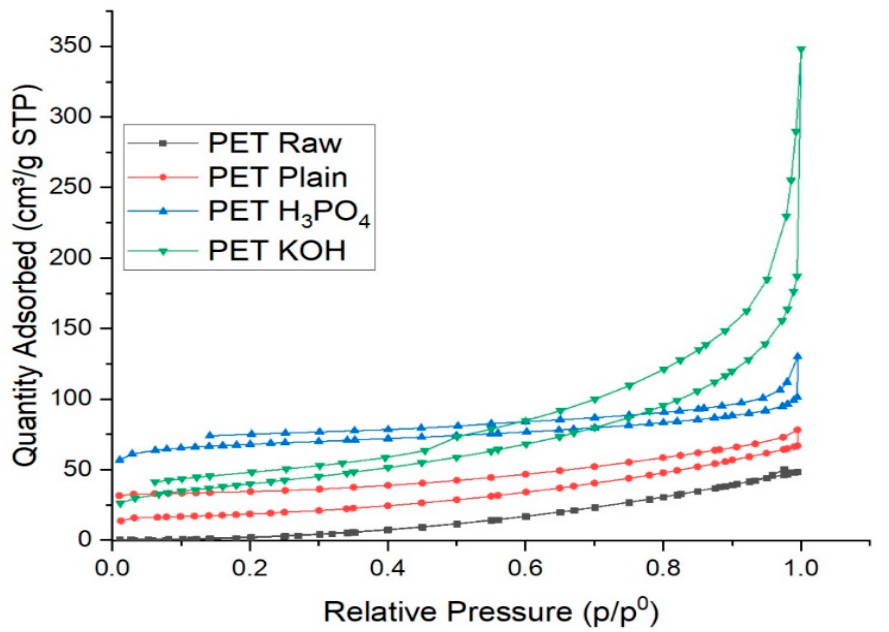
Figure 3. N 2 -adsorption and desorption isotherms of PET Raw, PET Plain, PET H 3 PO 4 and PET KOH.